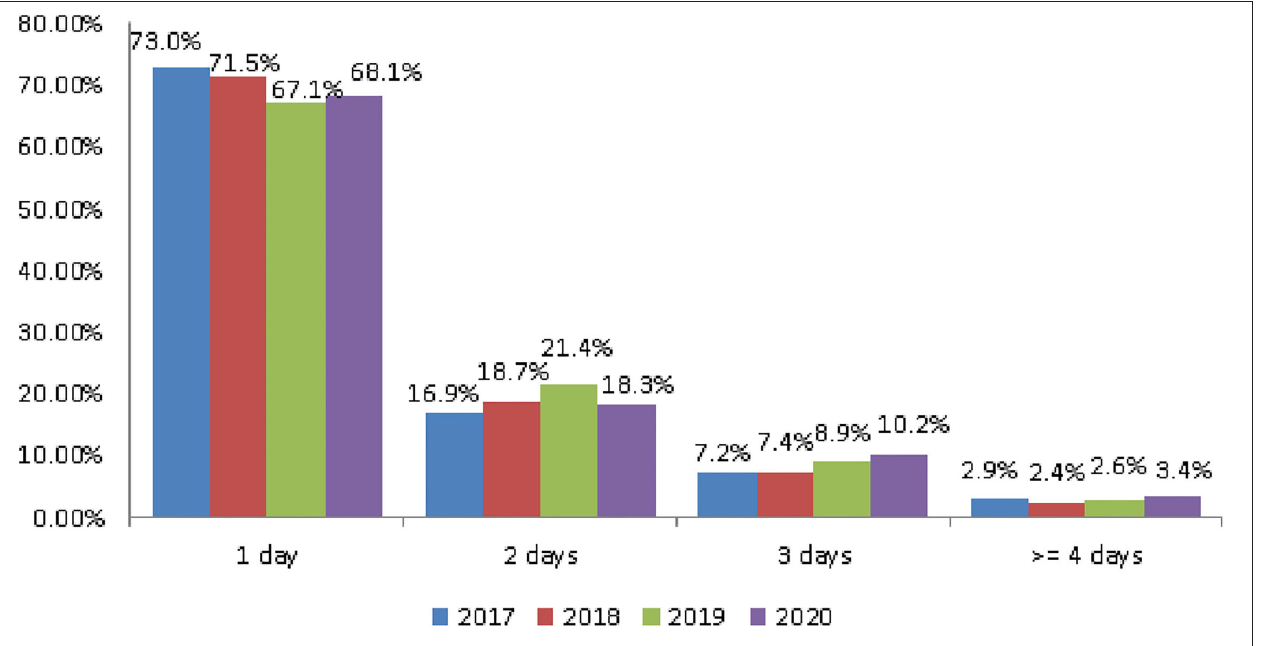
FIGURE 2 | The trend of tourism days.